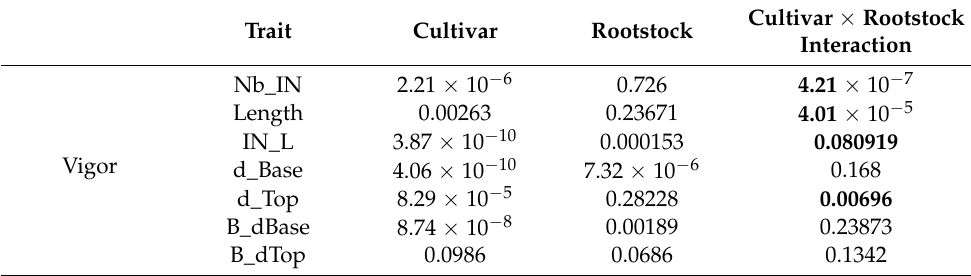
Table 2. Analysis of the effects of 30 almond scion–rootstock combinations on variability in architec- tural traits as affected by scion and rootstock genotype and the interaction between the two. Refer to Table 1 for